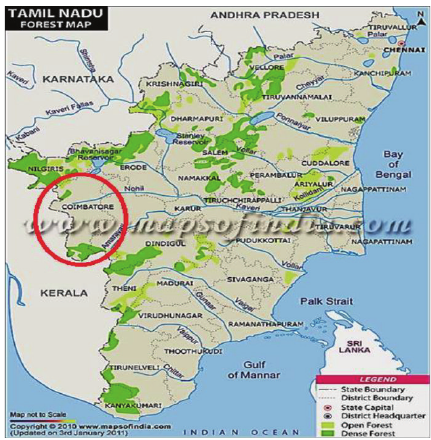
Figure 2: Corridors used by Elephants in the forest border area of